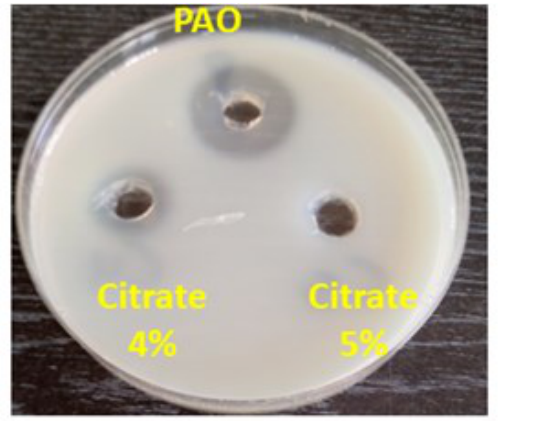
Figure 4. Sodium citrate reduces the production of P. aeruginosa virulent pigment. The absorbances of produced pyocyanin were measured in cultures provided or not with 4% or 5% sodium citrate. Sodium citrate significantly reduced pyocyanin production (*** = p < 0.0001).